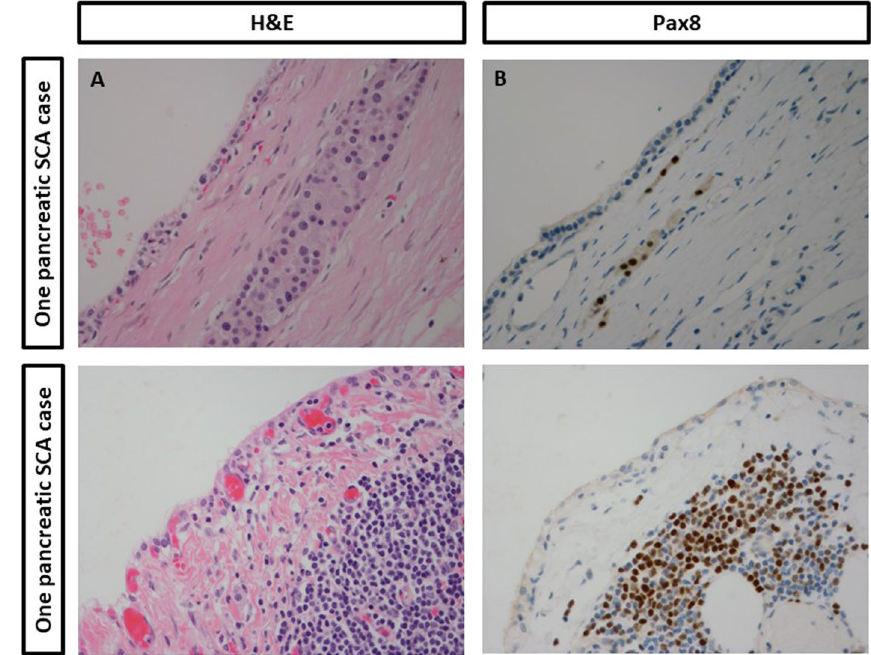
Fig. 3 Representative images from pancreatic serous cystadenoma (SCA) surgical resection cases. A , B One pancreatic SCA surgical resection case highlighting islet cells. C , D One pancreatic surgical resection SCA case highlighting lymphoid cells. A and C Hematoxylin and eosin (H&E) staining. B and D Pax8. Magnification 400 ( A – D ) = ×